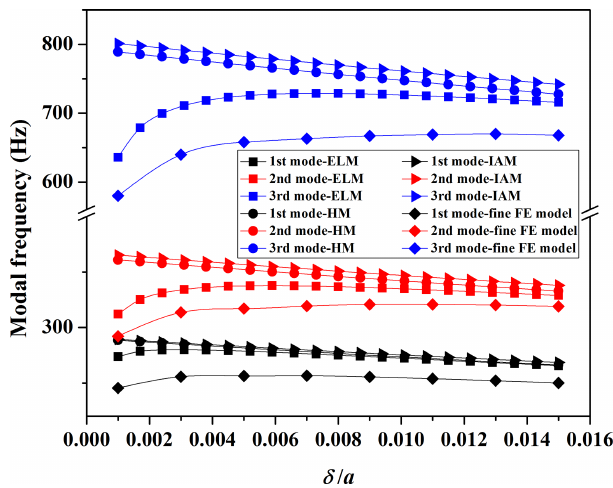
Figure 8. Effect of δ a on the dynamic characteristics